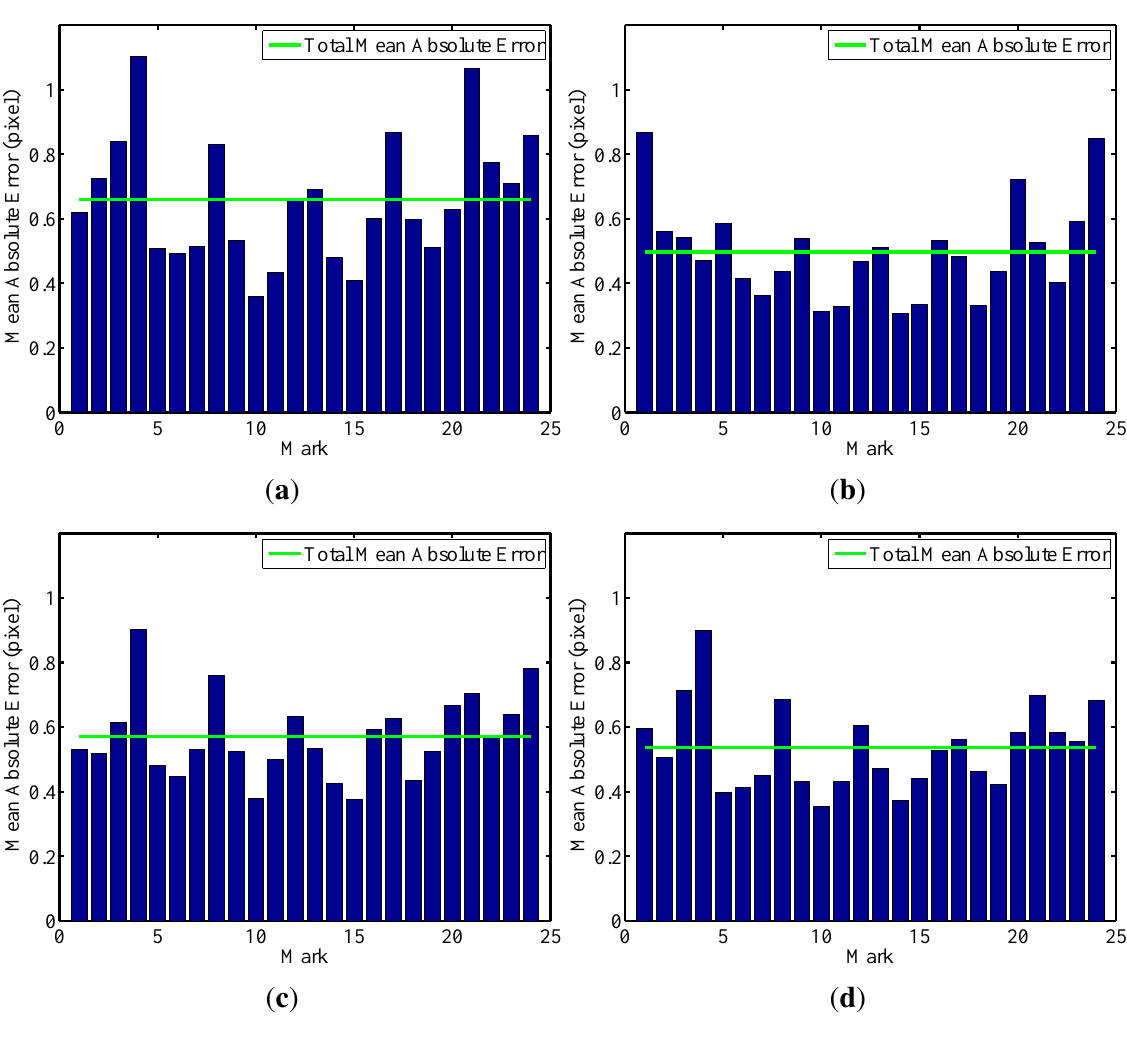
Figure 17. Reprojection error for the oval path. ( a ) Camera 1; ( b ) Camera 2; ( c ) Camera 3; ( d ) Camera